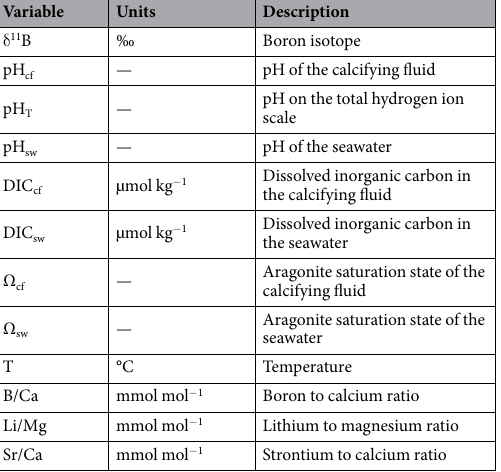
Table 1. Nomenclature. Definition of variables used in this